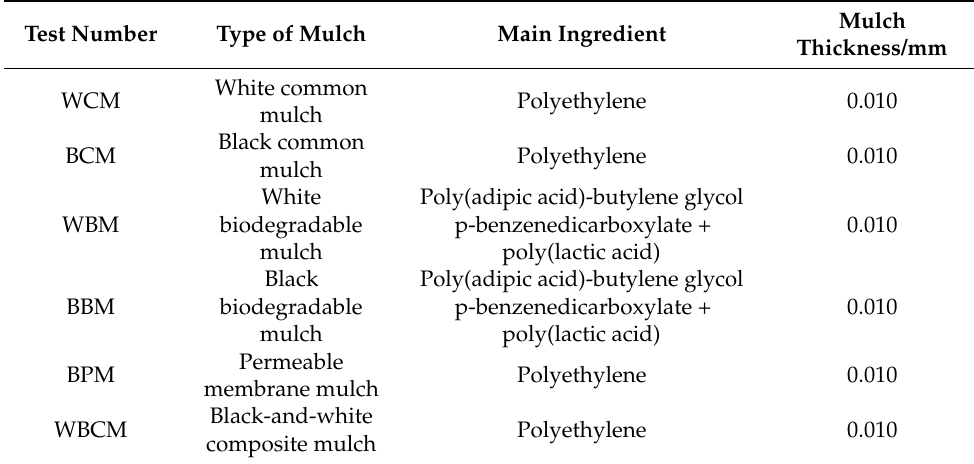
Table 1. Information parameters of different types of plastic mulch mulches.